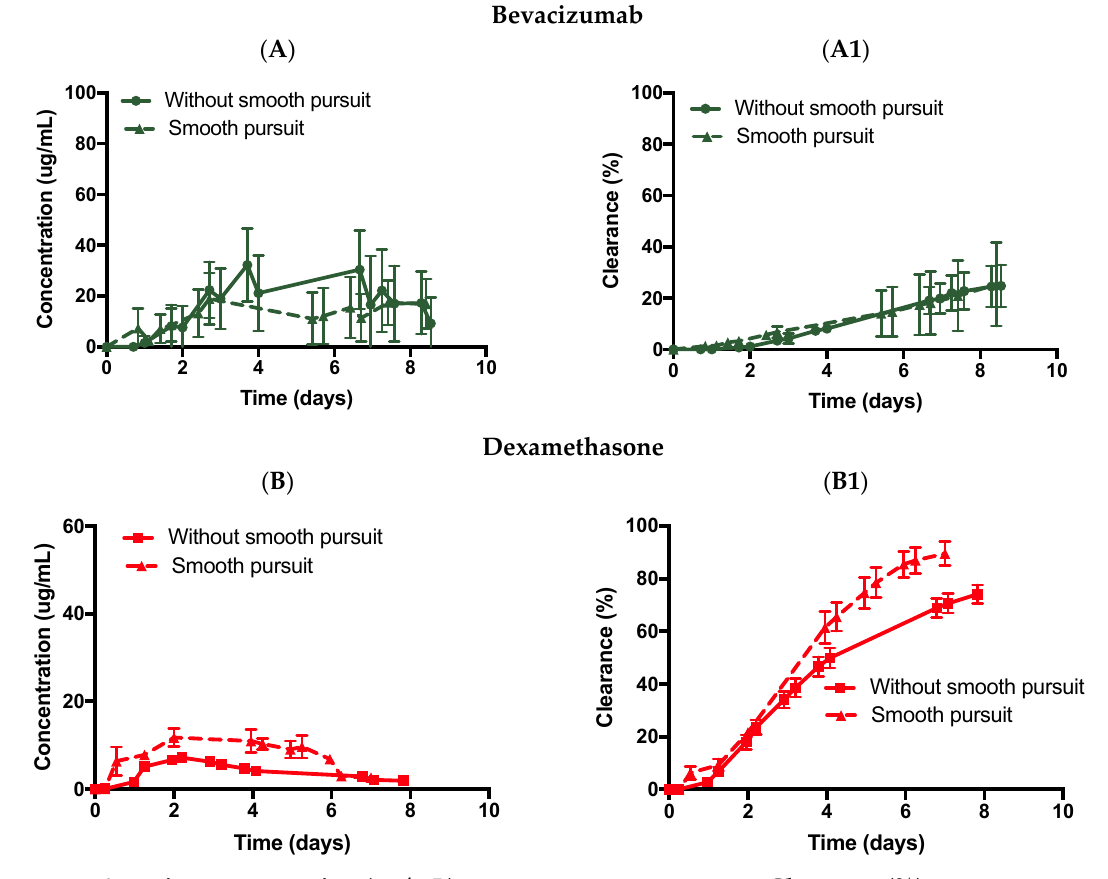
Figure 8. Effect of motion on the ciliary inflow model with ( A , A1 ) bevacizumab (1.25 mg, 50 µL) and ( B , B1 ) dexamethasone (0.1 mg, 100 µL) injected in PBS with and without slow pursuit. All data are presented as the mean (n = 3) and standard deviation (±STD).